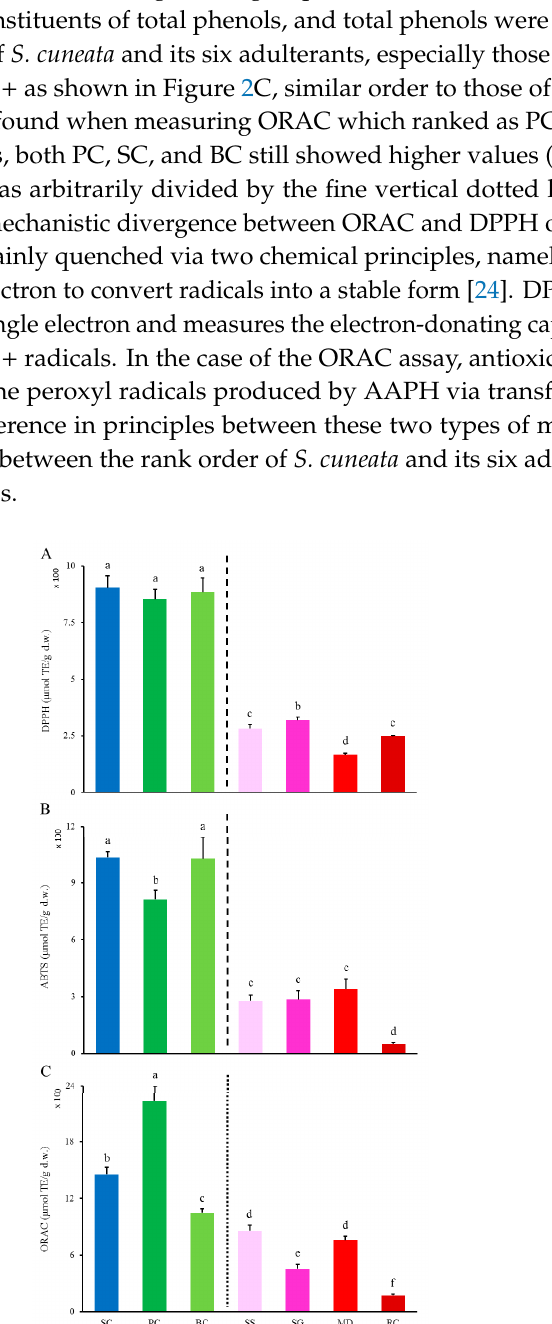
explanation of Figure 3C in Figure 3 caption Formatted: Font: Palatino Linotype, 10 pt